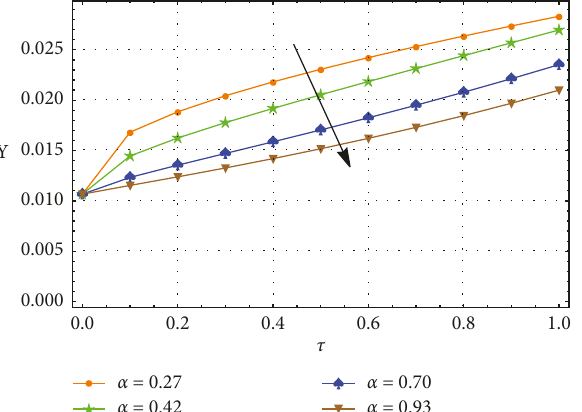
Figure 11: Evaluation of water surface level in Example 3 at different values of α when ρ � 1.5 and x � 10.